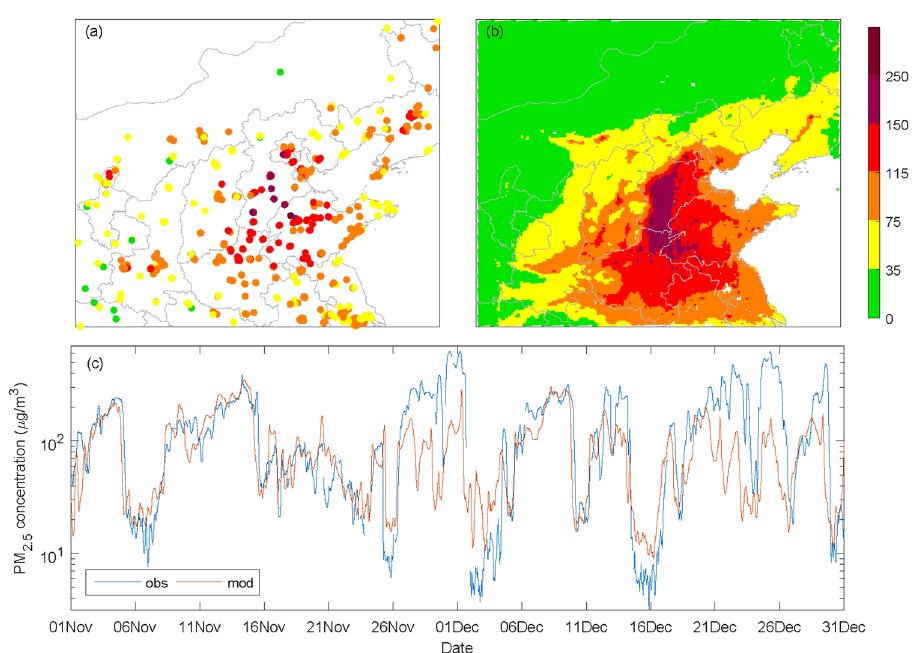
Figure 3. The spatial distribution of the observed ( a ) and simulated ( b ) mean PM 2.5 concentrations during the period of November 1 st to December 31 st and the temporal variations in the observed and simulated hourly PM 2.5 concentrations in downtown Beijing ( c